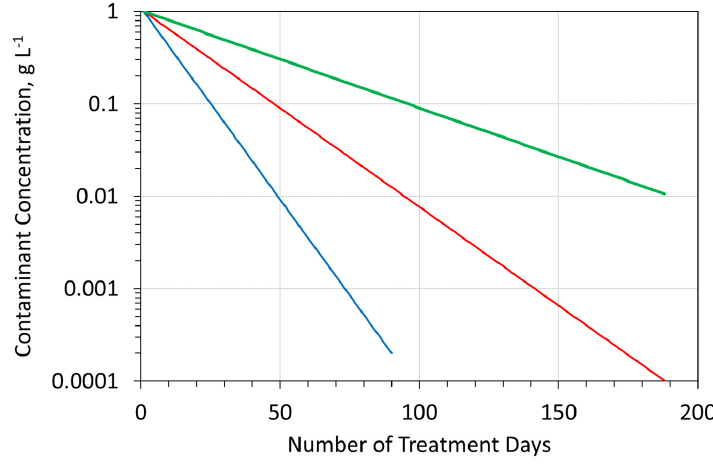
Figure A5. Relationship between surface based reactor, ion removal efficiency, time, and contam- inant concentration in the groundwater mound. Blue is base case; red and green = lower ion removal efficiencies.